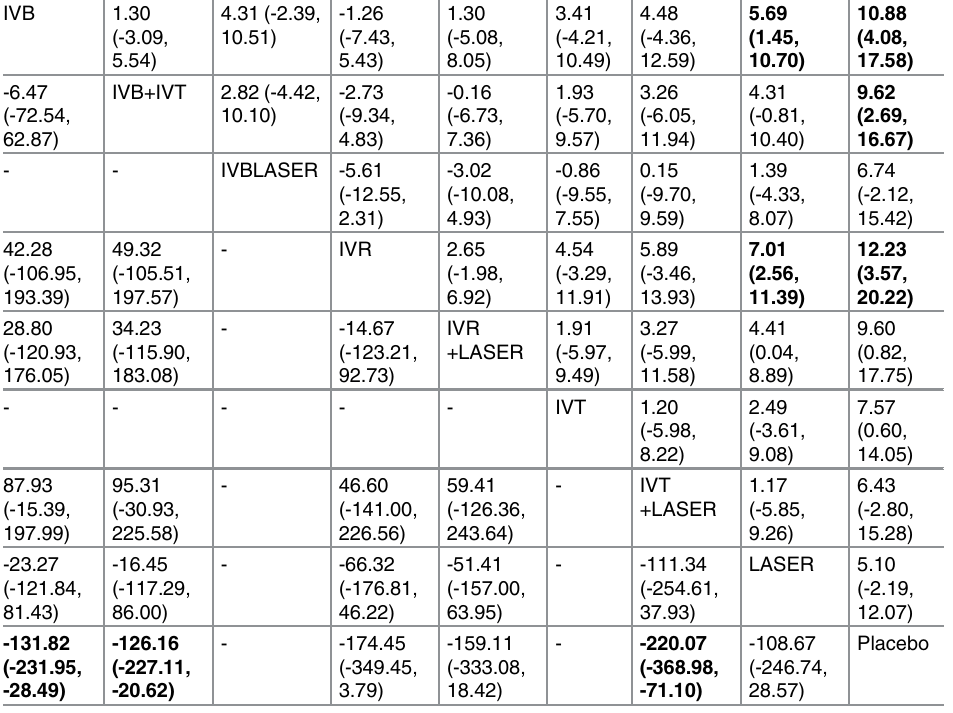
IVB, intravitreal bevacizumab; IVR, intravitreal ranibizumab; LASER, laser, macular laser, grid laser and focal/grid laser; IVT, intravitreal